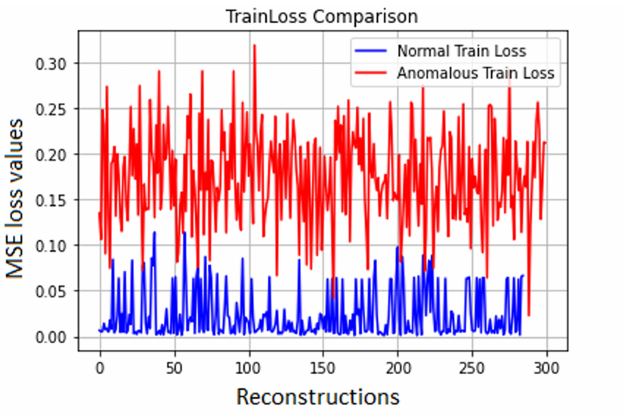
Figure 8. Graphic of the prediction loss values on normal traffic data and abnormal traffic data.